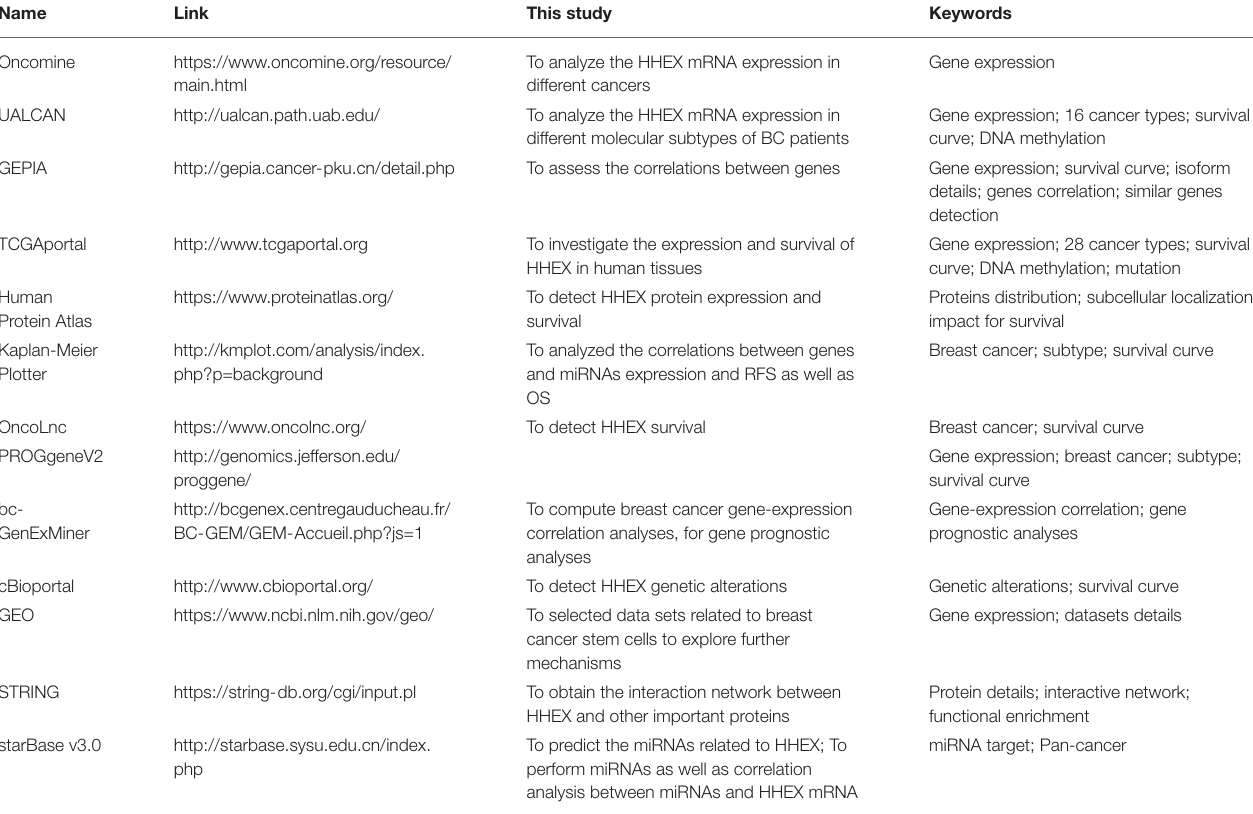
TABLE 1 | Summary of databases used in this study.